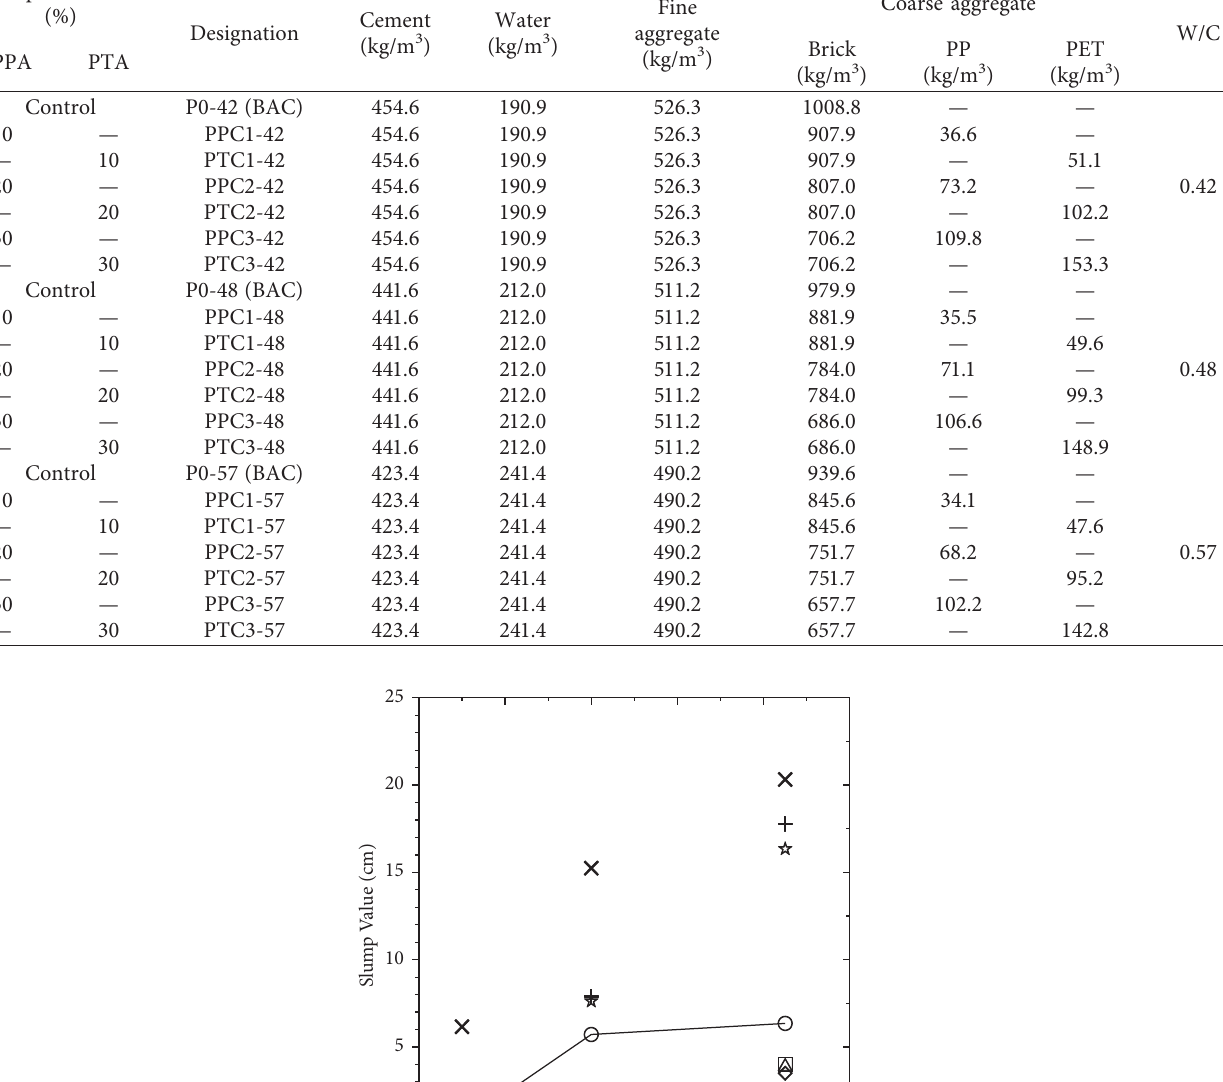
Table 3: Mix design for 1m 3 of concrete.